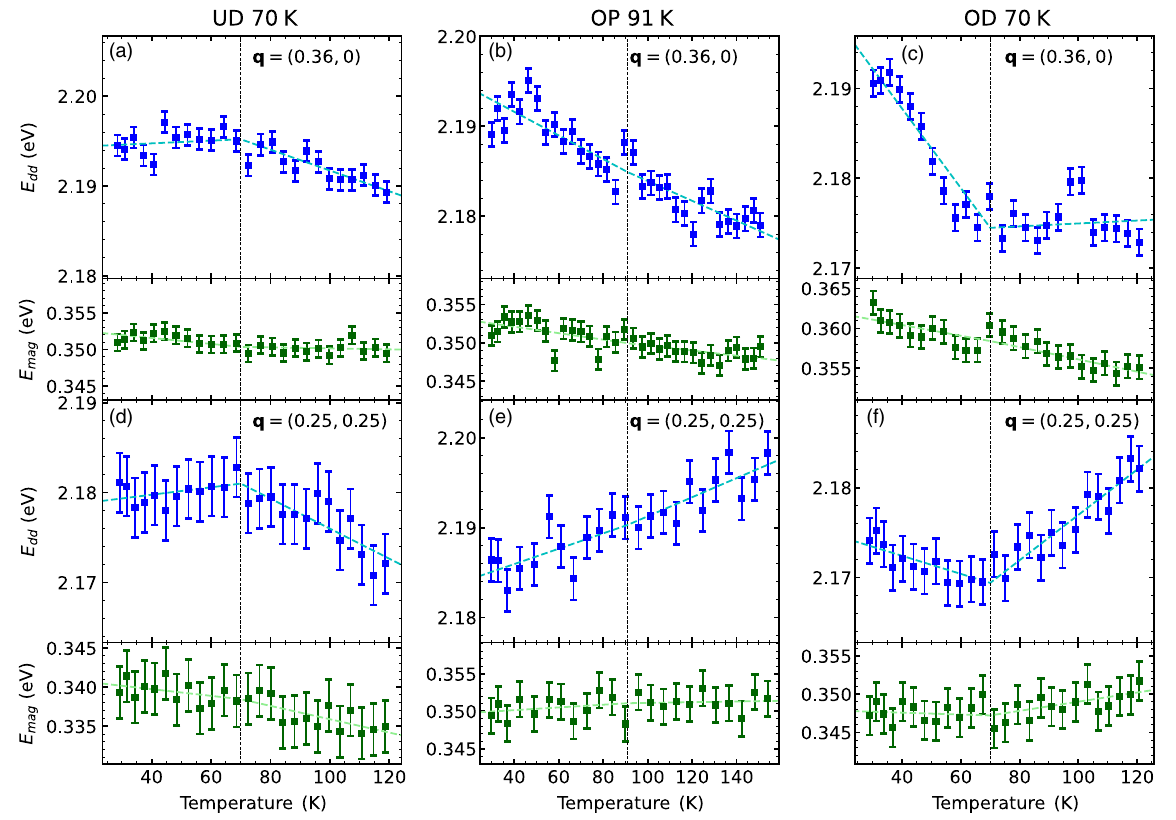
FIG. 3. Temperature dependence of the first moment of the dd exciton peak and the magnon peak, as extracted from the experimental spectra (considering, respectively, the energy intervals 1 – 4 and 0.1 – 0.6 eV). The dashed lines are fits to a curve parametrized as Eq. (2). The error bars represent the uncertainty on the elastic peak position computed as explained in Appendix A. The vertical dotted lines indicate T . Top panels: momentum value (0.36, 0). Bottom panels: momentum value (0.25, 0.25). (a),(d) Underdoped Bi-2212 c ¼ 70 K). (b),(e) Optimally doped Bi-2212 ( T ¼ 91 K). (c),(f) Overdoped Bi-2212 ( T ¼ 70 ( T c c c